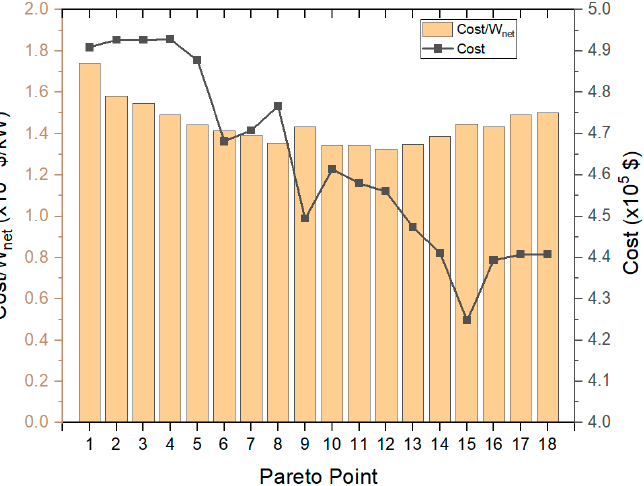
Figure 8. The cost per unit net output power and the cost of the ORC at the Pareto frontier point.